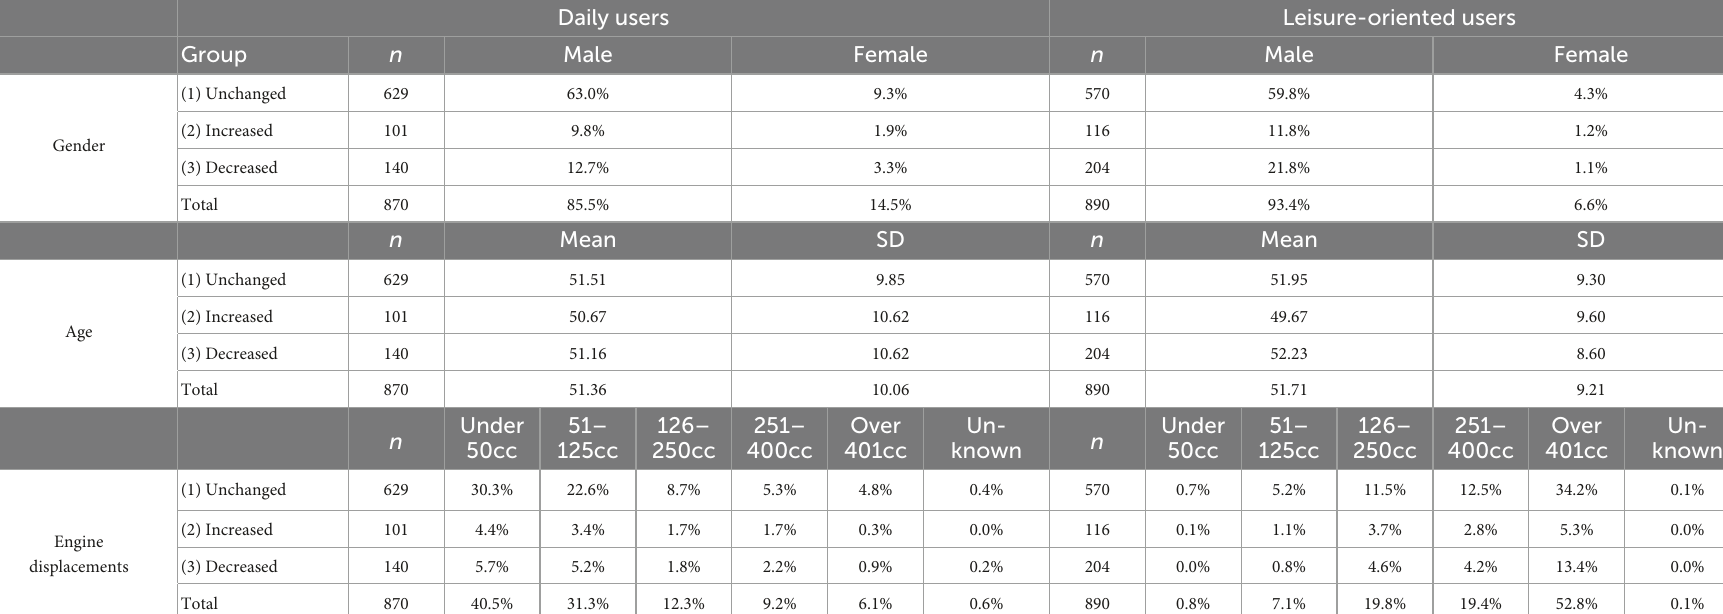
TABLE 1 Gender and age of respondents and their motorcycles’ engine